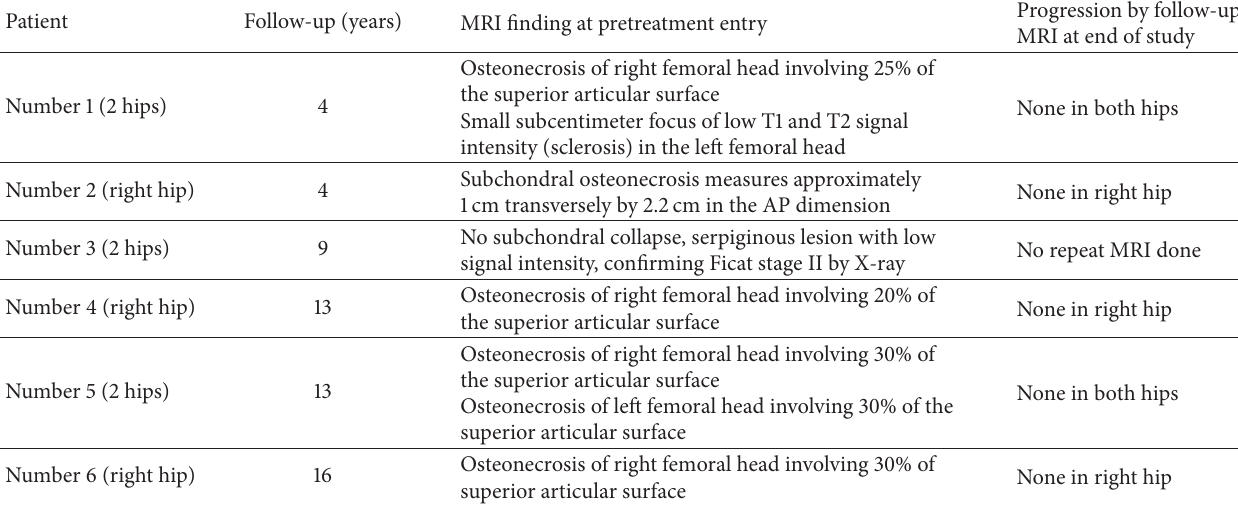
Table 2: Six patients, 9 hips (5 heterozygous for the V Leiden mutation, 1 with resistance to activated protein C). Anticoagulation for 4–16 years. Entry MRI and nonprogression by